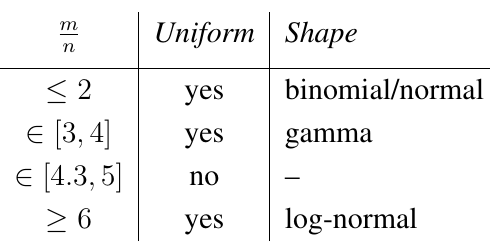
Table 1. Runtime distribution